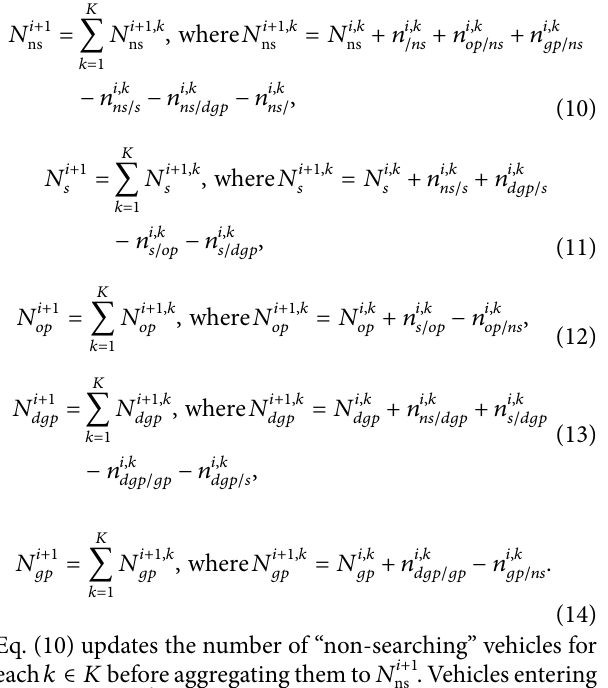
Figure 3: Simple example of uniformly distributed garage parking to illustrate the average walking distance in Eq.